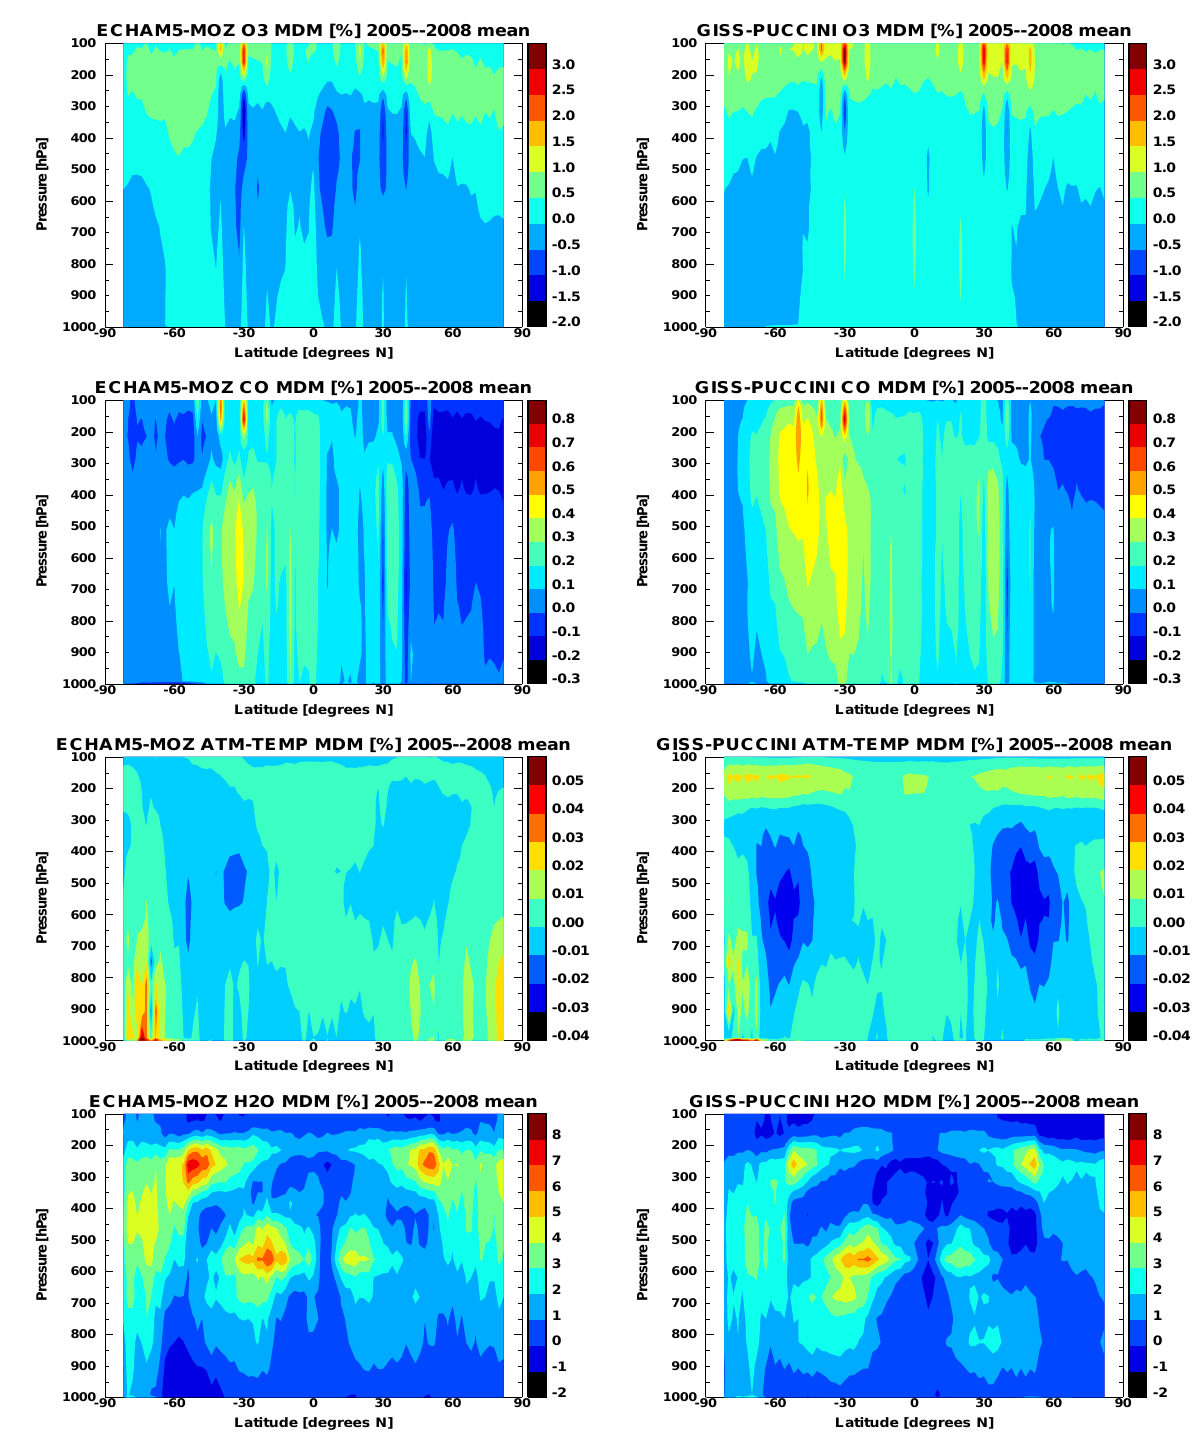
Fig. 8a. The 2005–2008 monthly-mean zonal average of the percentage error introduced by using the monthly-mean satellite operator approximation in the ECHAM5-MOZ (left column) and GISS-PUCCINI (right column) models. The influence of monthly-mean averag- ing kernel on ozone, carbon monoxide, atmospheric temperature and water vapour are shown on the first, second, third and fourth rows